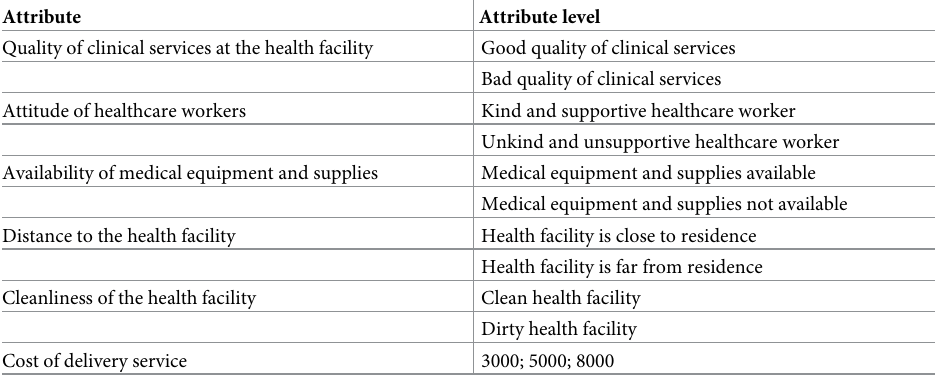
Table 1. List of attributes and attribute levels included for the DCE. Attribute Attribute level Quality of clinical services at the health facility Good quality of clinical services Bad quality of clinical services Attitude of healthcare workers Kind and supportive healthcare worker Unkind and unsupportive healthcare worker Availability of medical equipment and supplies Medical equipment and supplies available Medical equipment and supplies not available Distance to the health facility Health facility is close to residence Health facility is far from residence Cleanliness of the health facility Clean health facility Dirty health facility Cost of delivery service 3000; 5000;